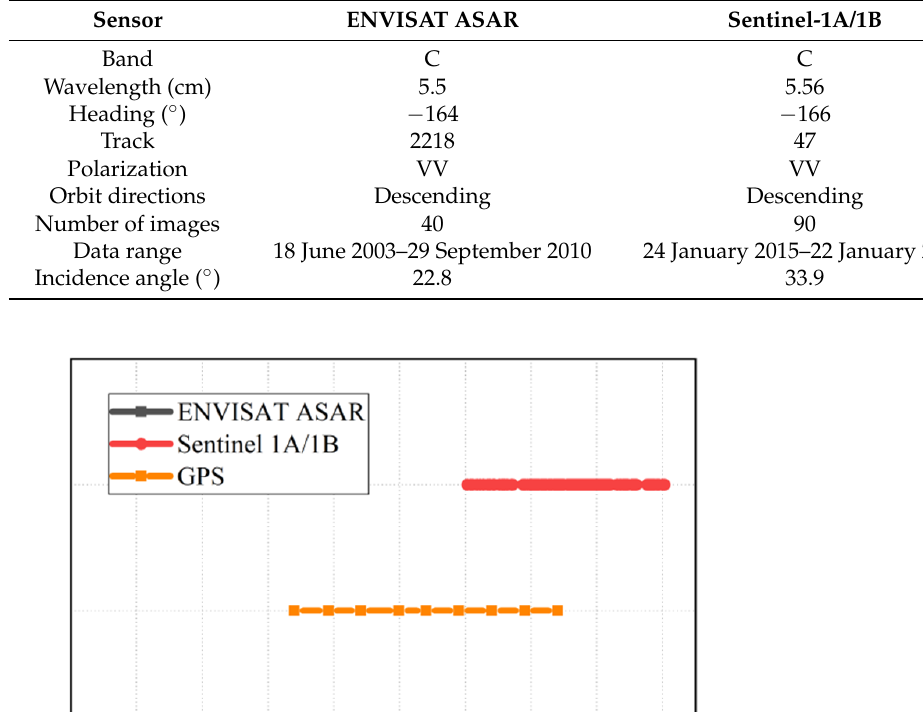
Table 1. Information of the SAR dataset.